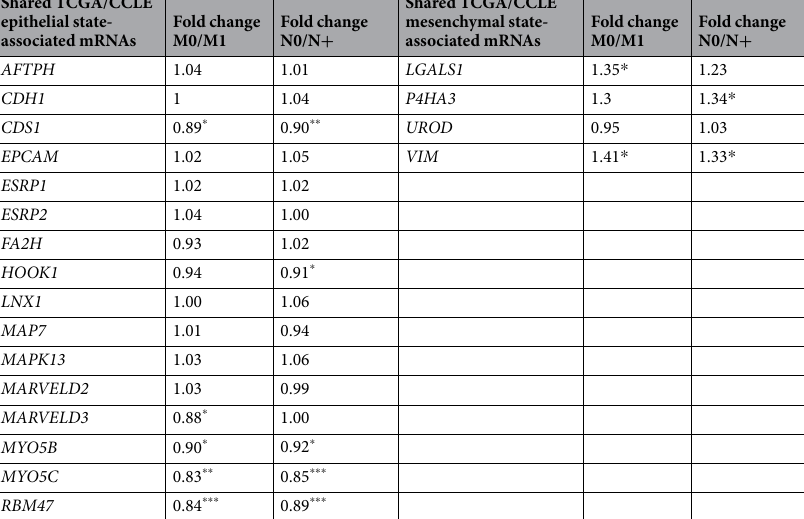
Table 2. Shared TCGA/CCLE epithelial state- and mesenchymal state-associated mRNAs and their associations with distant metastasis and nodal status in the TCGA COAD cohort. Fold change: average expression of indicated mRNAs in primary tumors from patients without distant metastases (M0) or negative nodal status (N0) divided by average expression of indicated mRNAs in primary tumors from patients with distant metastases (M1) or positive nodal status (N + ). * P < 0.05; ** P < 0.01; *** P <